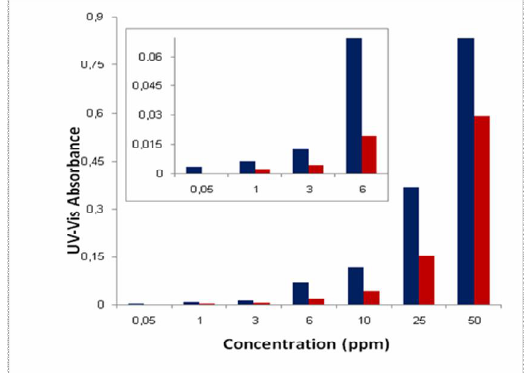
Fig. 7. UV-Vis absorbance of wastewater (left) before treatment and (right) after treatment for different concentrations of Bromocresol green.